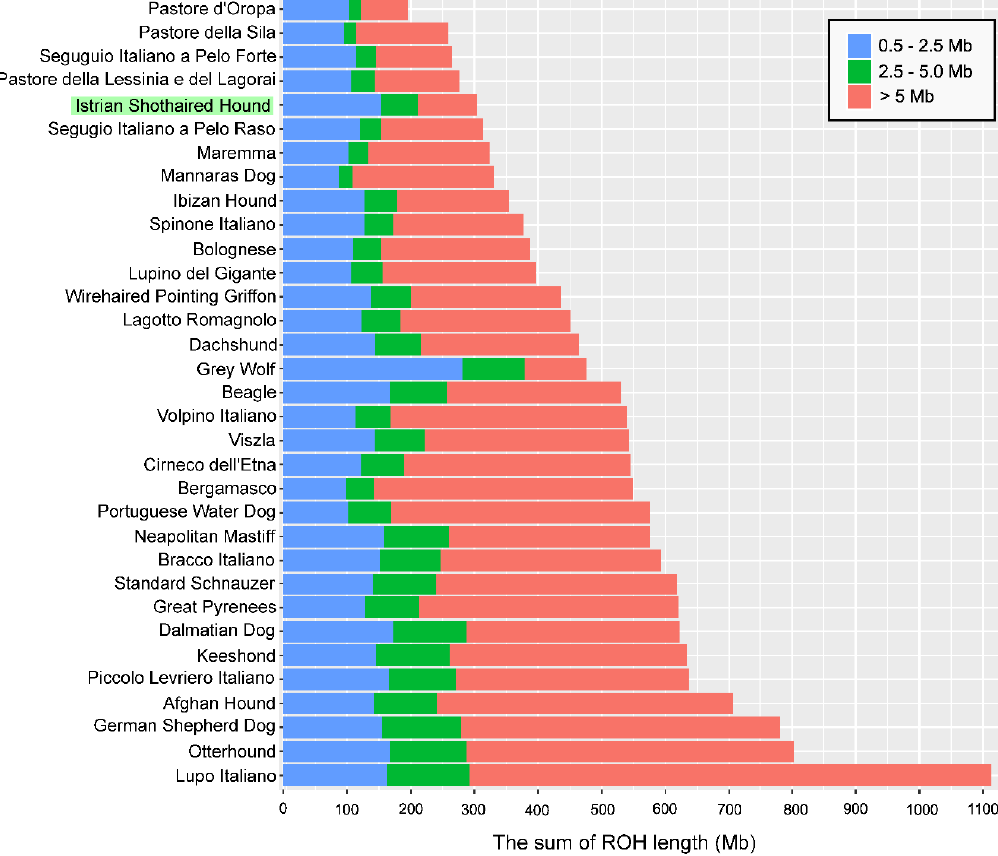
Table 4. ROH summary: mean number of ROH (N ROH ), mean ROH length (L ROH ) and mean genome